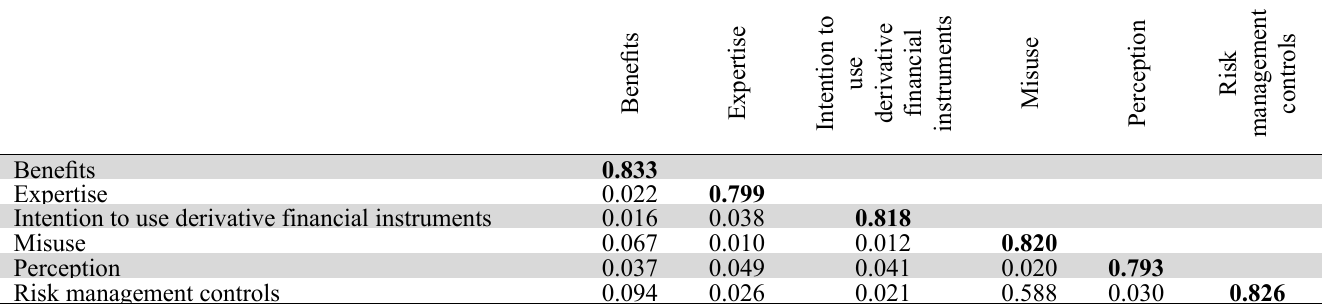
Discriminant Validity (Fornell-Larcker Criterion)